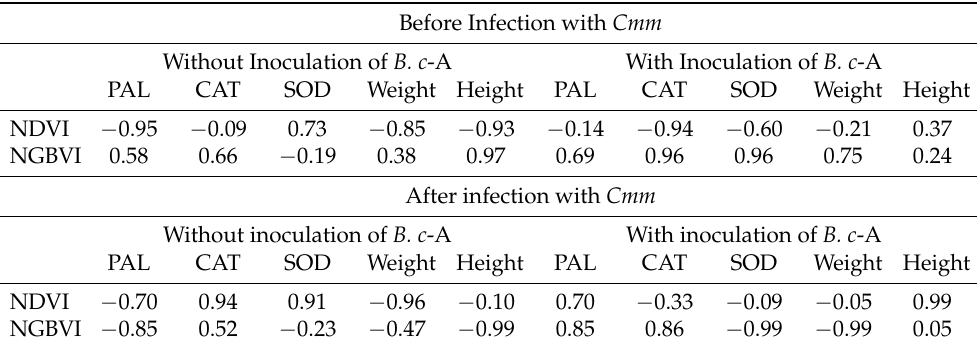
Table 2. Correlation values of the NDVI and NGBVI before and after infection with Cmm . Before Infection with Cmm Without Inoculation of B. c -A With Inoculation of B. c -A PAL CAT SOD Weight Height PAL CAT SOD Weight Height NDVI After infection with Cmm Without inoculation of B. c -A With inoculation of B. c -A PAL CAT SOD Weight Height PAL CAT SOD Weight Height NDVI 0.94